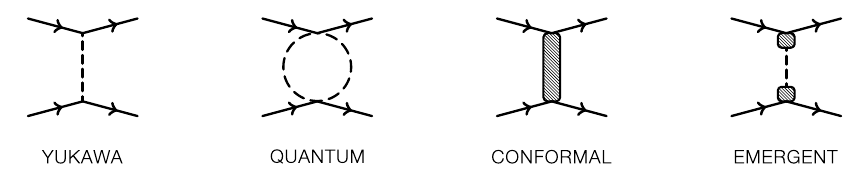
Figure 1 . t -channel diagrams generating long-range forces in the scenarios we consider. Shaded regions represent strong